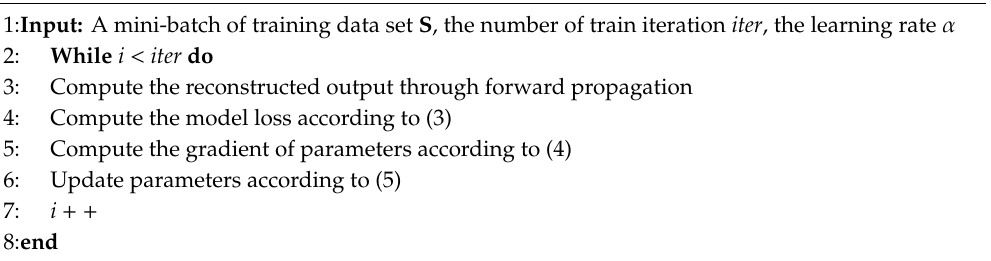
Algorithm 1: Training of the Stacked CBN-VAE